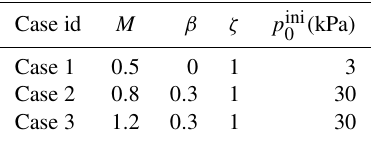
Table 1. Deposition height and volume of snow in simulations with different M and in the field observation.